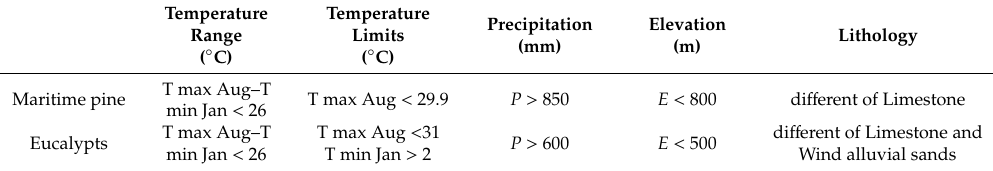
Table 3. Variables and thresholds defining species ecological envelopes